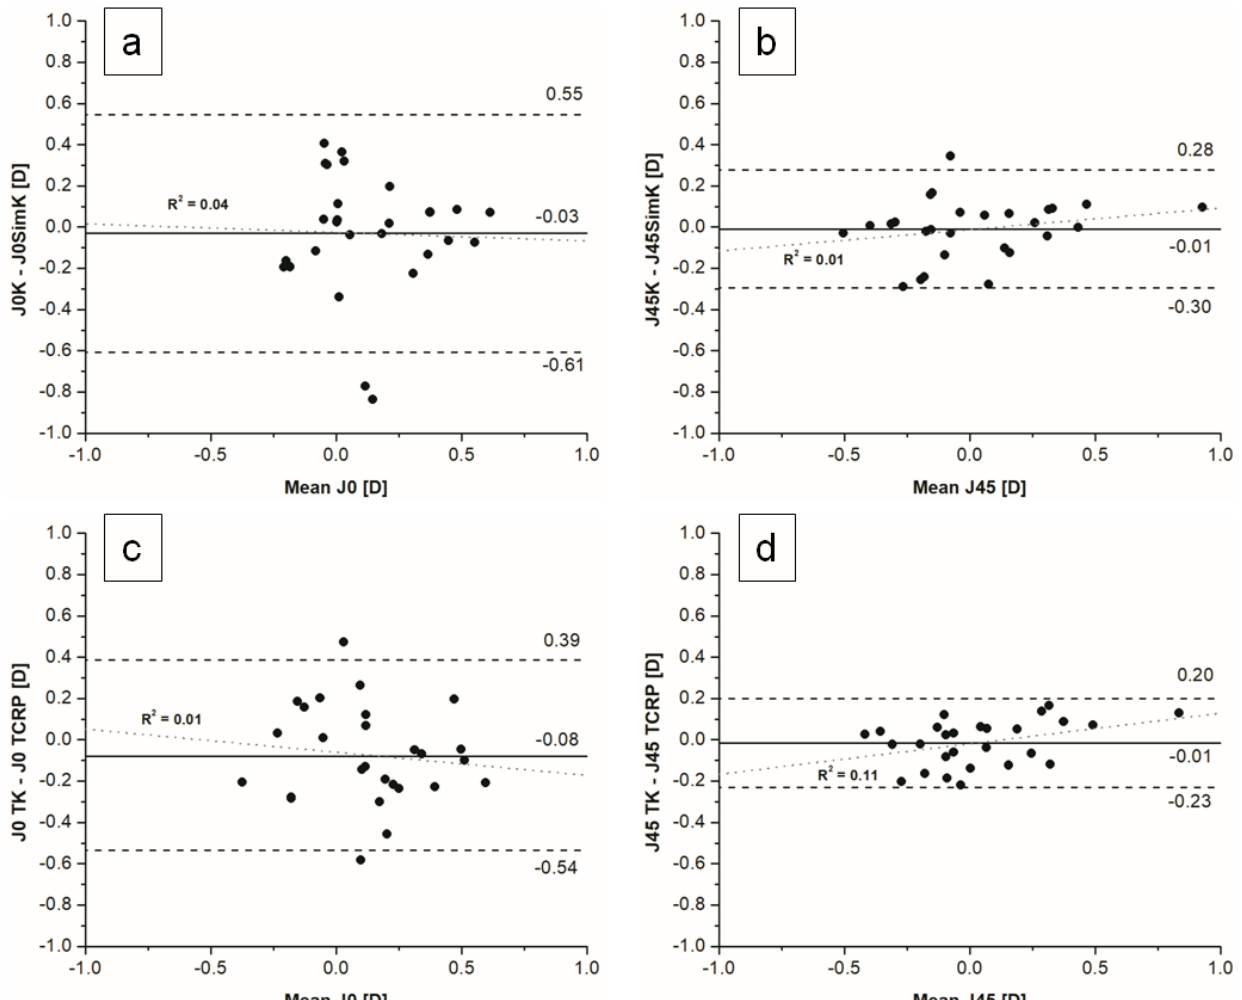
Figure 4. Bland – Altman plots for astigmatism vector analysis for K and simK ( a ) J0, ( b ) J45 and for TK and TCRP ( c ) J0, ( d ) J45.